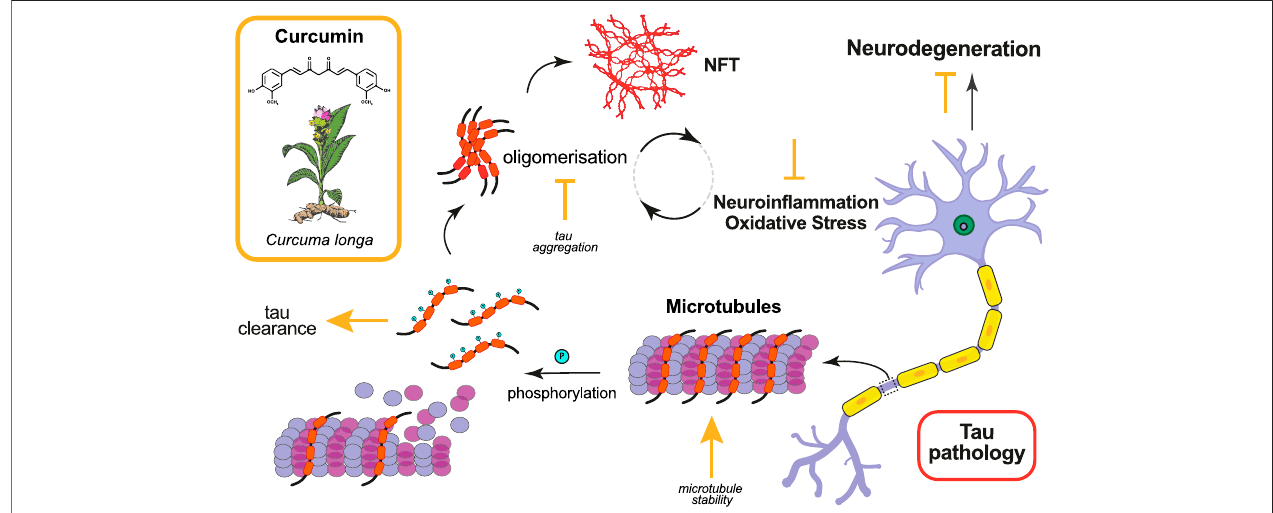
FIGURE 1 | Effects of curcumin in ameliorating tau pathology. Curcumin and its derivatives have been shown to ameliorate tau pathology in animal models by targeting various molecular mechanisms. The mode of action of curcumin, whether promotive (arrow) or inhibitive (falsum), is indicated in yellow next to the process it modi fi